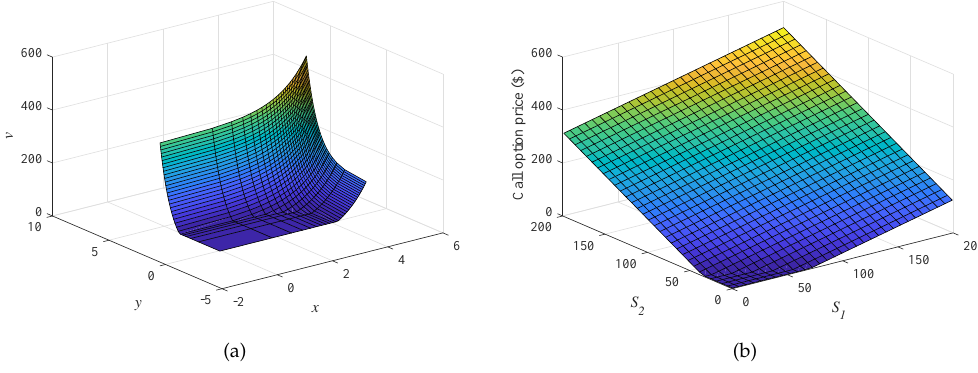
Figure 1. ( a ) Transformed explicit solution, v , and ( b ) call option price, c , for α = 0.9 at a day before an expiration date.